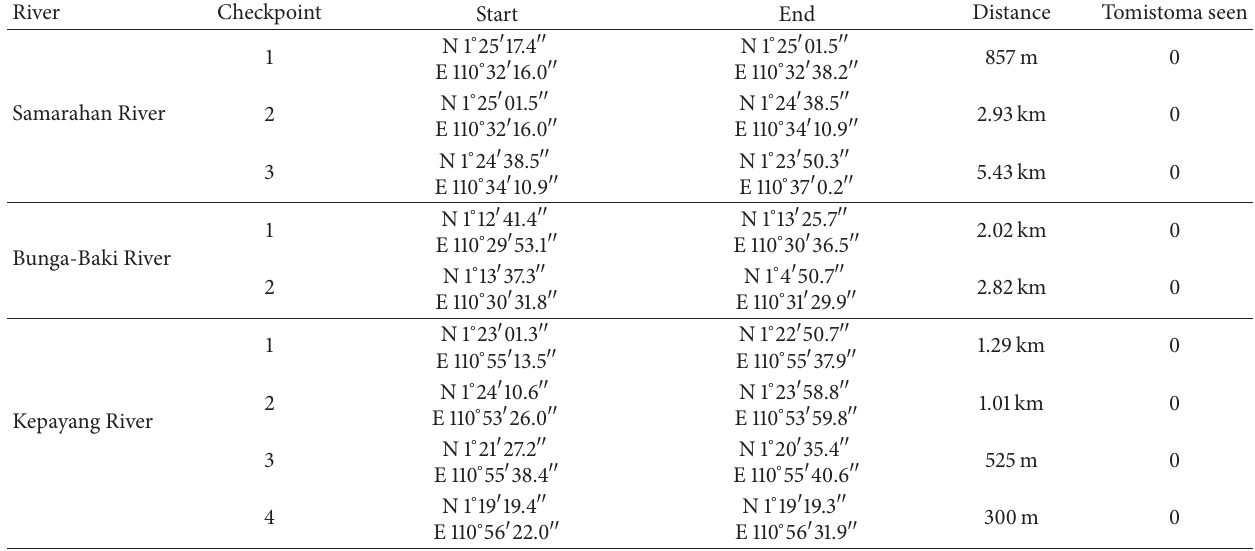
Table 1: Location and distance of rivers surveyed (on foot and using small boats). River Checkpoint Start End Distance Tomistoma